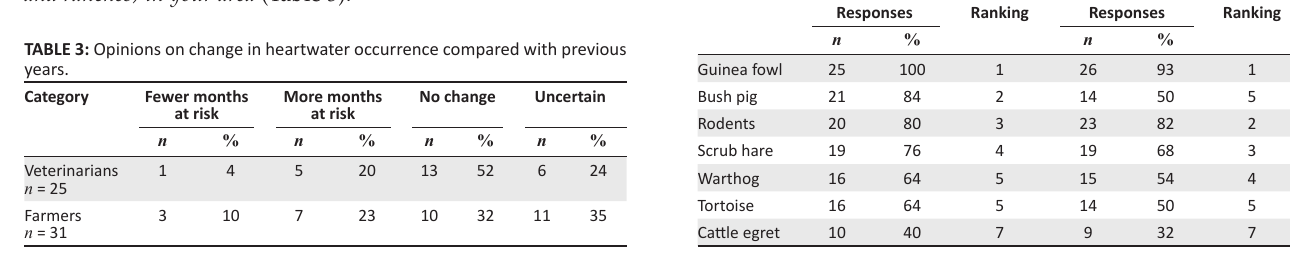
TABLE 4: Rating of factors that could contribute to changes in the occurrence of heartwater. Factors